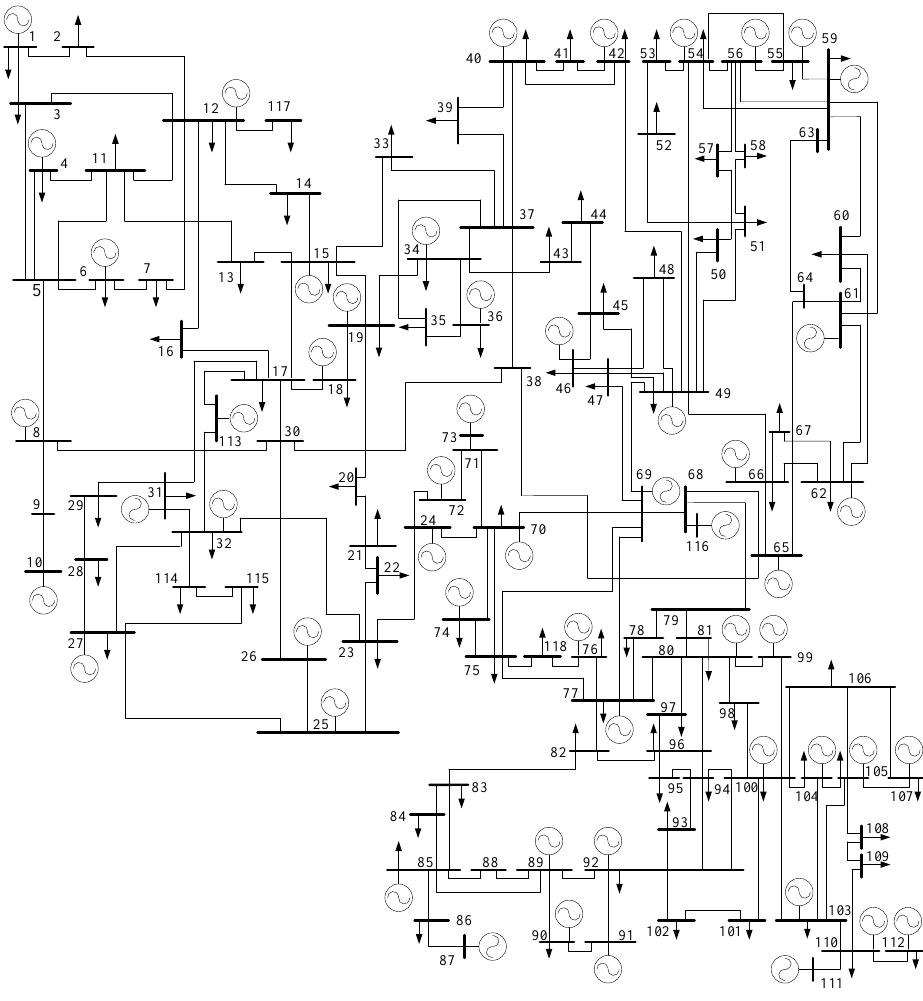
Figure 4. IEEE 118-bus system single line diagram. Table 1. Partial sub-networks and their